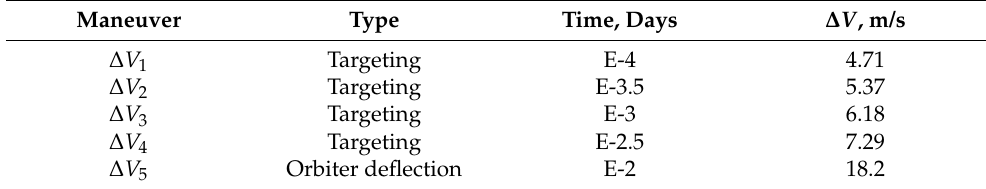
Table 14. Venus small satellite constellation targeting and orbiter deflection maneuvers.